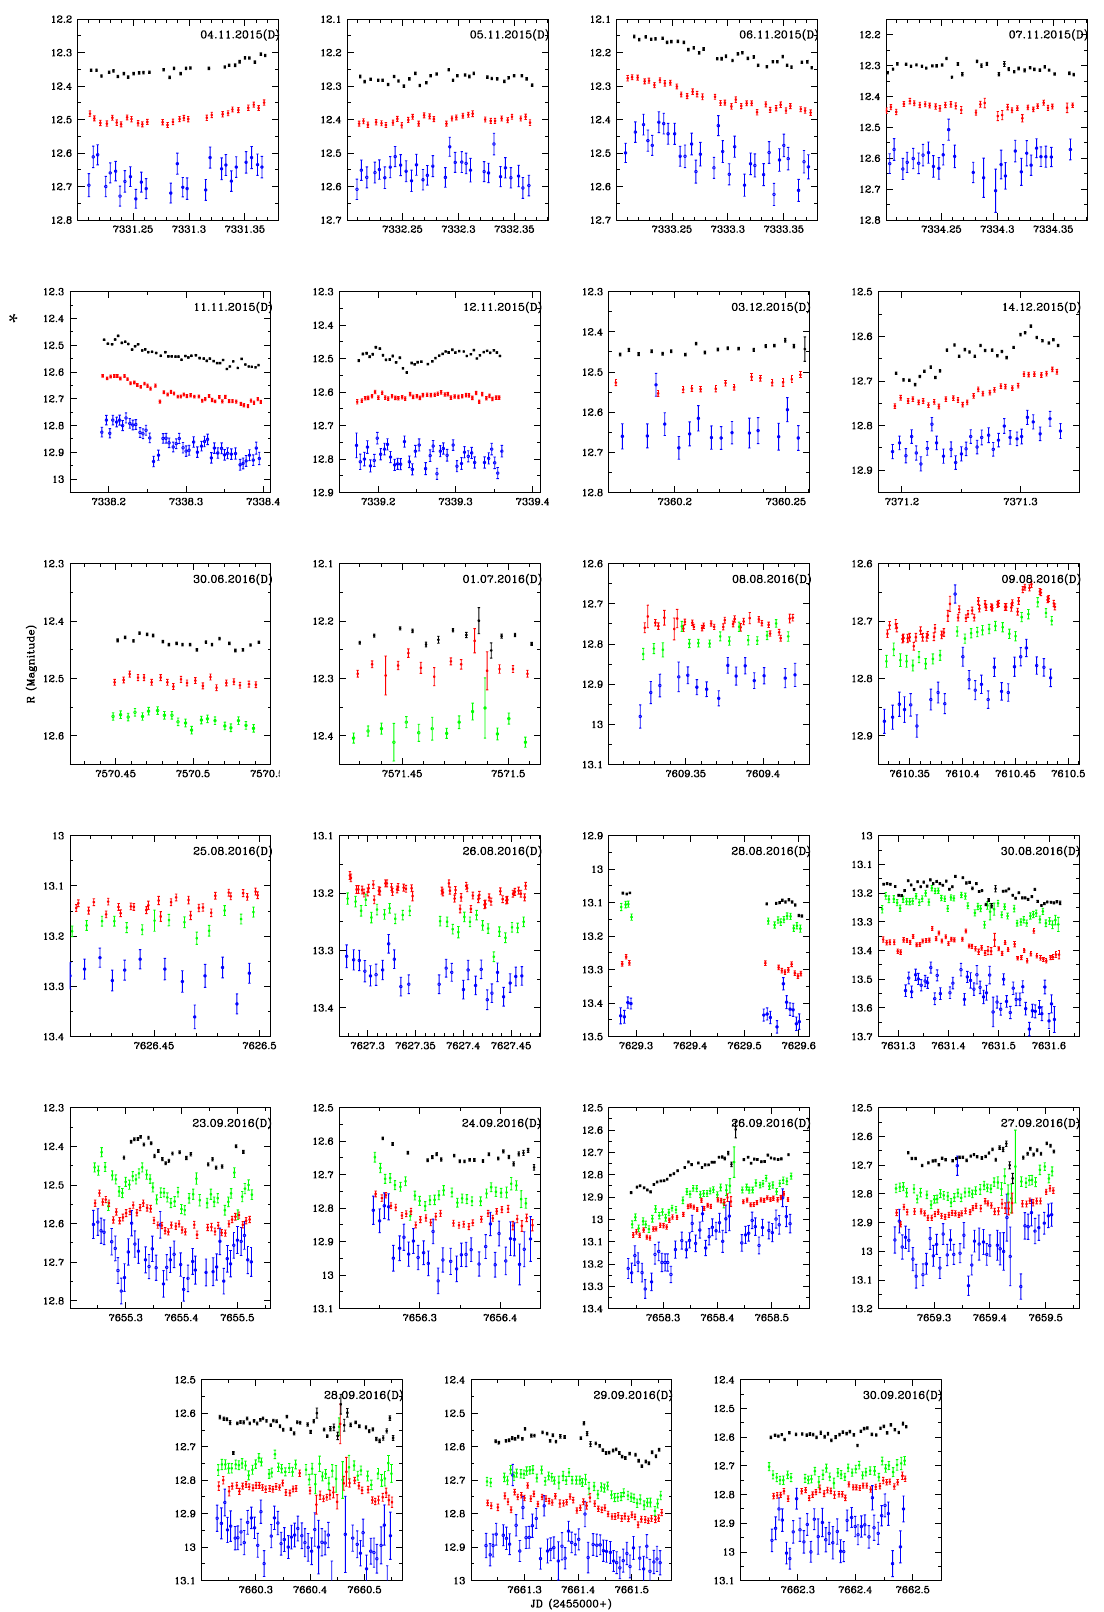
Figure 2. As in Figure 1, for November 2015 through September